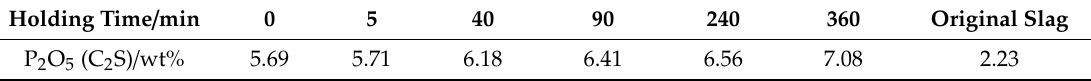
Table 3. Content of phosphorus in C 2 S with di ff erent holding times at 1673 K.